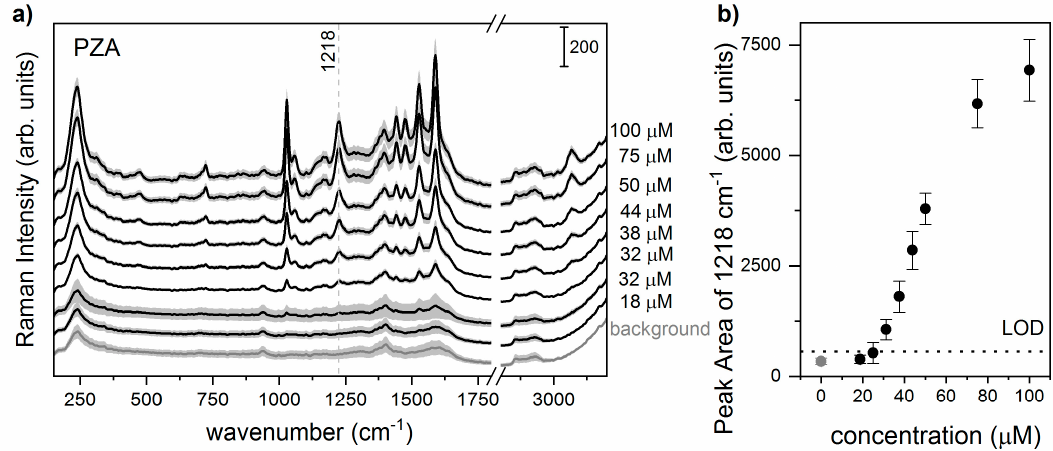
Figure 3 . ( a ) Lab-on-a-chip SERS (LoC-SERS) mean spectra of different concentrated PZA in water as indicated in the plot. The standard deviation values are indicated in grey; ( b ) the integrated intensity of the marked peak centered at 1218 cm − 1 .